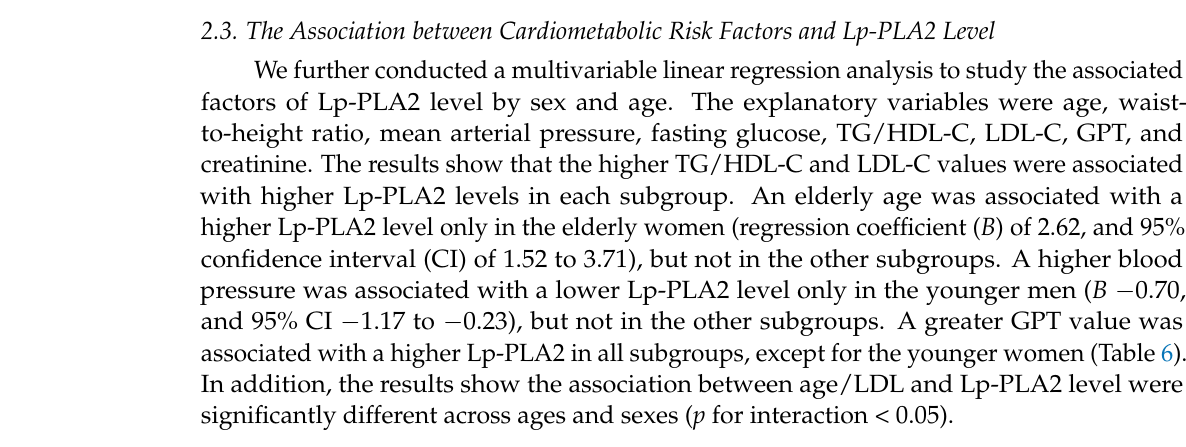
creatinine. The results show that the higher TG/HDL-C and LDL-C values were associated with higher Lp-PLA2 levels in each subgroup. An elderly age was associated with a higher Lp-PLA2 level only in the elderly women (regression coefficient ( B ) of 2.62, and 95% confidence interval (CI) of 1.52 to 3.71), but not in the other subgroups. A higher blood pressure was associated with a lower Lp-PLA2 level only in the younger men ( B − 0.70, and 95% CI − 1.17 to − 0.23), but not in the other subgroups. A greater GPT value was associated with a higher Lp-PLA2 in all subgroups, except for the younger women (Table 6). In addition, the results show the association between age/LDL and Lp-PLA2 level were significantly different across ages and sexes ( p for interaction <